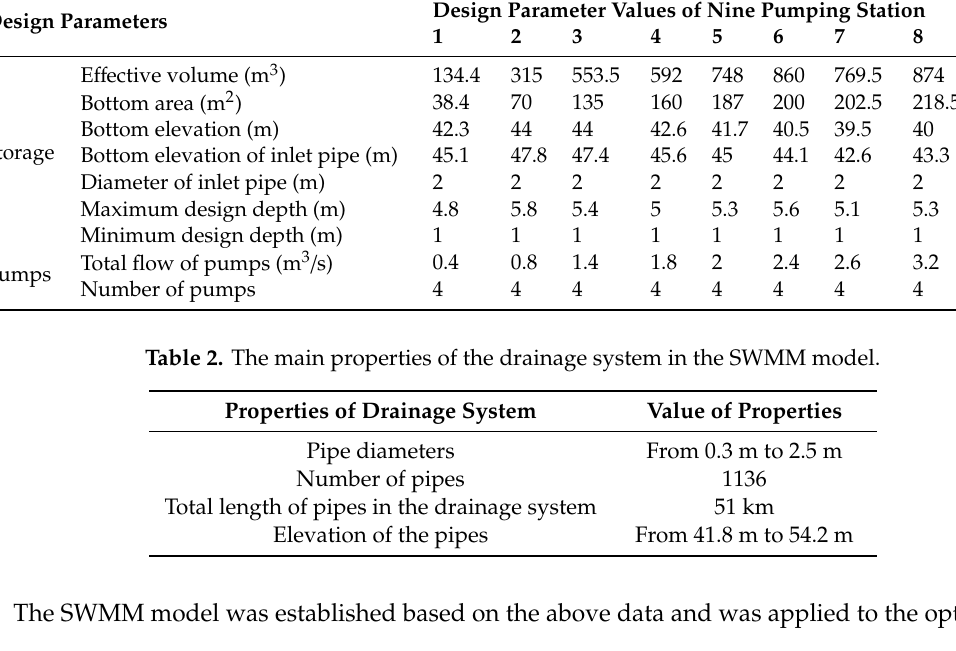
Figure 3. The SWMM (Storm Water Management Model) model for the study area. The white square in the figure is the locations of nine pump stations. Table 1. Design parameters of the nine pumping stations.